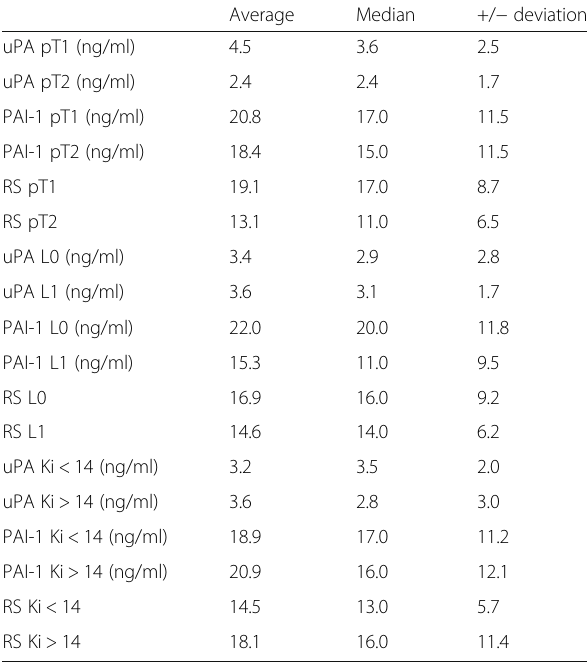
Table 2 Protein levels for uPA/PAI-1 (ng/ml) and Recurrence Score (RS) from multigenetest in different variables